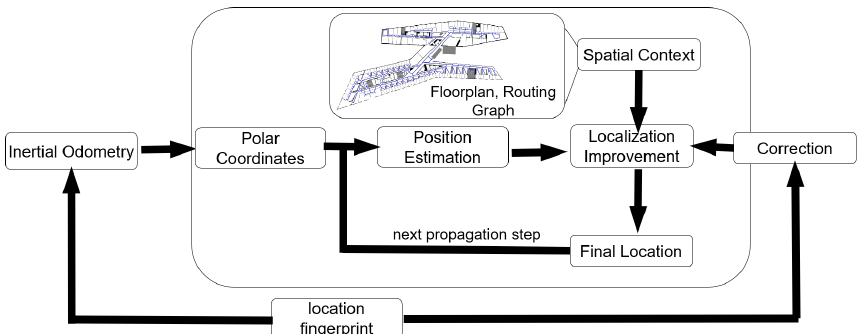
Figure 1. Overview of the structure of the developed algorithm that uses particle filtering as a map-matching process. Starting from a position derived, for example, through a location fingerprint, odometry data from inertial measurements are transferred to polar coordinates, resulting in the estimation of the propagated position. This estimation is improved via spatial constraints and further corrected by additional information from the location fingerprint, resulting in the final position estimate, which serves as the starting point for the next propagation